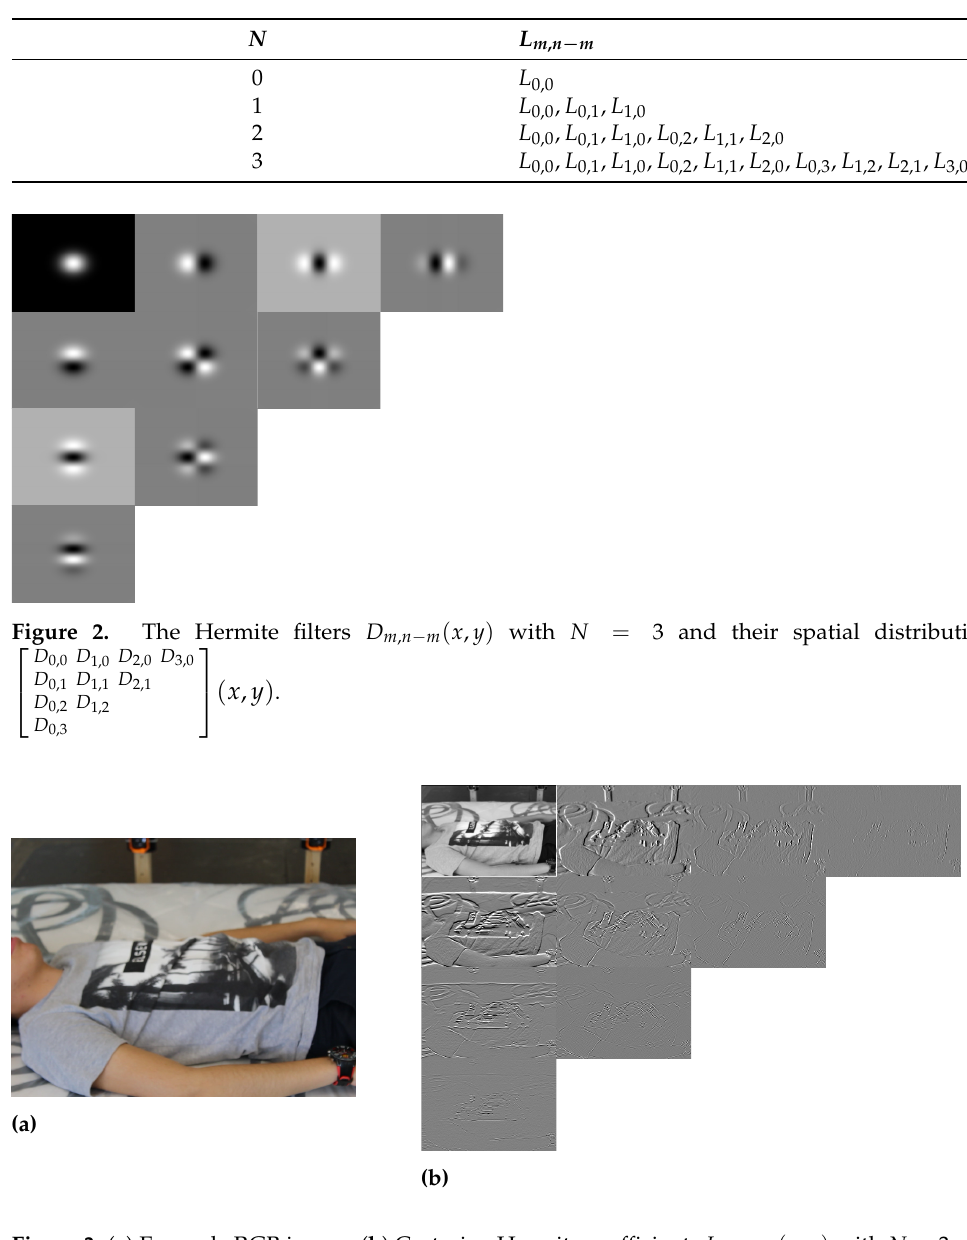
Figure 3. ( a ) Example RGB image. ( b ) Cartesian Hermite coefficients L m , n − m ( x , y ) with N = 3 and spatial